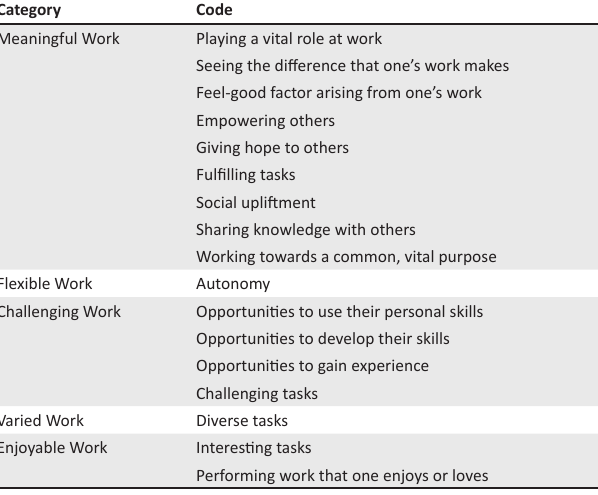
TABLE 2: Summary of categories and codes for the theme ‘intrinsic